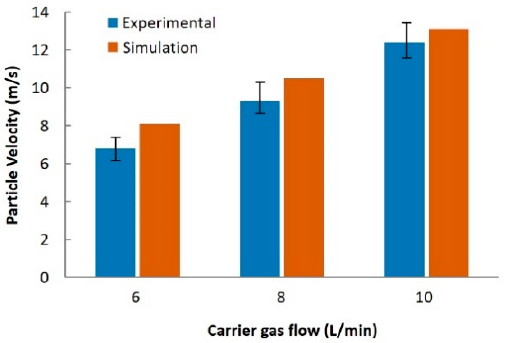
Figure 5. Comparison of simulation and experimental results of the particle velocity.